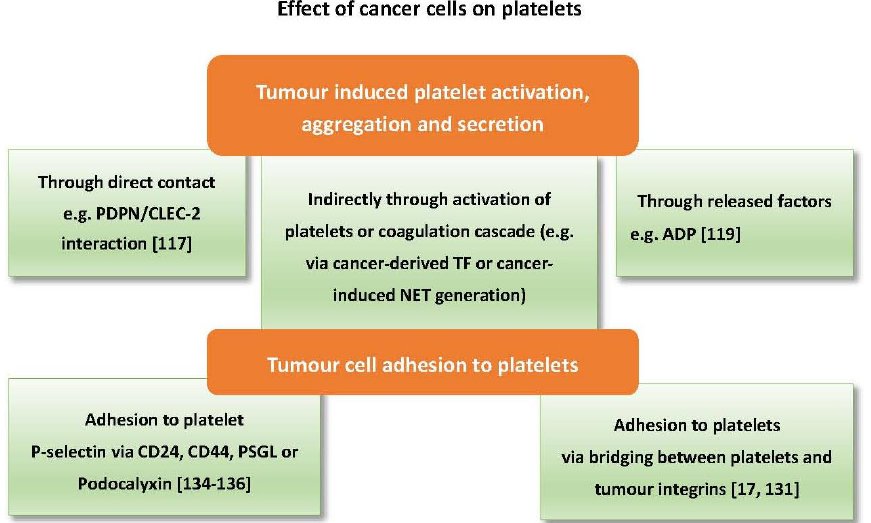
Figure 3. Summary of cancer cell-platelet interactions. Cancer cells can activate platelets through expression or release of platelet agonists (e.g. PDPN and ADP). Cancer cell-derived tissue factor (TF) can also indirectly activate platelets via the coagulation cascade and generation of thrombin. Cancer cells can also express ligands (e.g., CD24, PSGL, and integrins) that facilitate cancer cell-platelet adhesion.